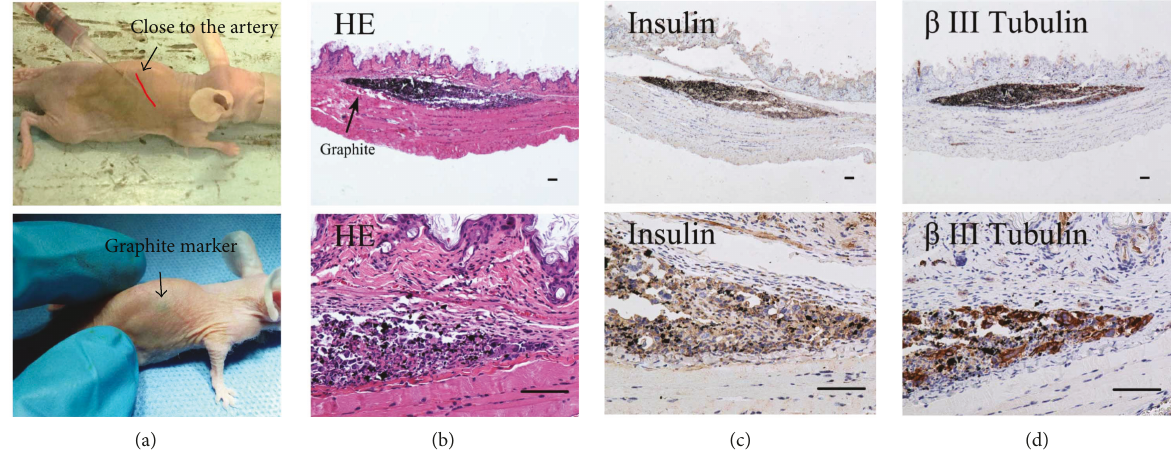
Figure 9: HE and immunohistochemistry staining of heterotypic pseudoislet grafts. (a) Heterotypic PIs mixed with graphite were injected subcutaneously into the back of STZ diabetic nude mice ( n = 4 ). The injection site was close to the dorsal artery. Four STZ diabetic mice with graphite marker were only used in histological examination and they were not be used in the previous experiments due to graphite markers. (b) Para ffi n sections were stained with hematoxylin and eosin at day 5. (c, d) INS-1 cells and NG108-15 cells were characterized by staining with insulin and β -III tubulin in serial sections. (b, c, and d) Scale bars represent 100 μ